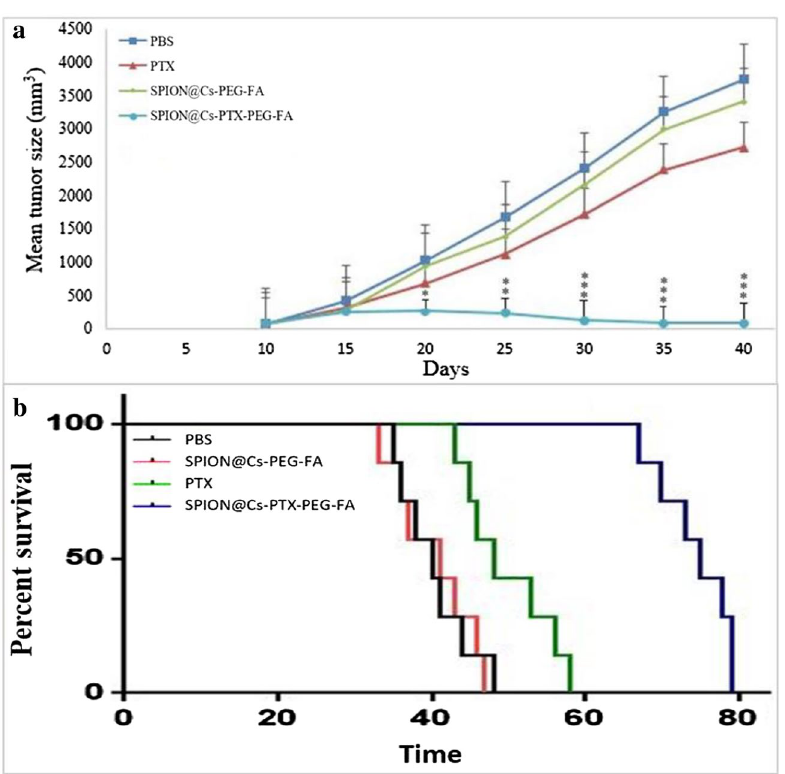
Figure 18. In vivo antitumor effects of SPION@Cs-PTX-PEG-FA in a mouse tumor model. Changes in tumor size were observed in representational mice (four groups). On day 19, tumor growth in mice treated with SPION@Cs-PTX-PEG-FA was reduced significantly (the values in the graph indicate the mean ± SD; *p < 0.05, **p < 0.01 and ***p < 0.001, represent significant differences between the control (untreated) and other treatments) relative to that of the other groups that received free PTX, SPION@Cs-PEG-FA, and